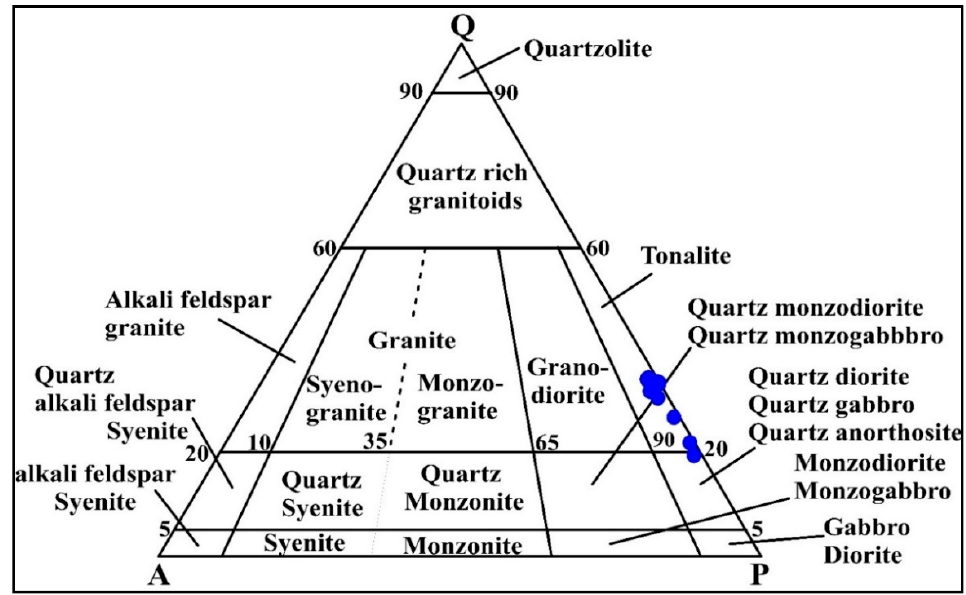
Figure 3. Classification of Abu Dabbab plagiogranites by using CIPW norms [47].